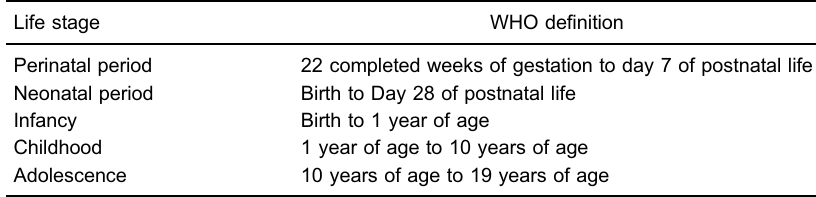
Table 1. De fi nitions of the stages of early life.